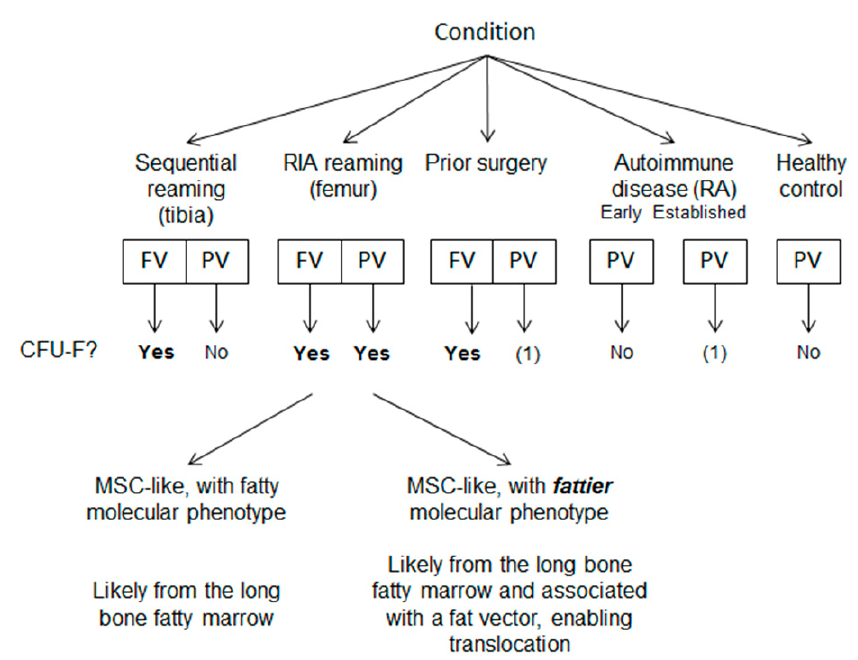
Figure 6. Study-wide summary of CFU-F findings. Yes = CFU-Fs found in multiple donors, No = CFU-F never found in designated group, (1) = only one colony found from all donors in designated group.